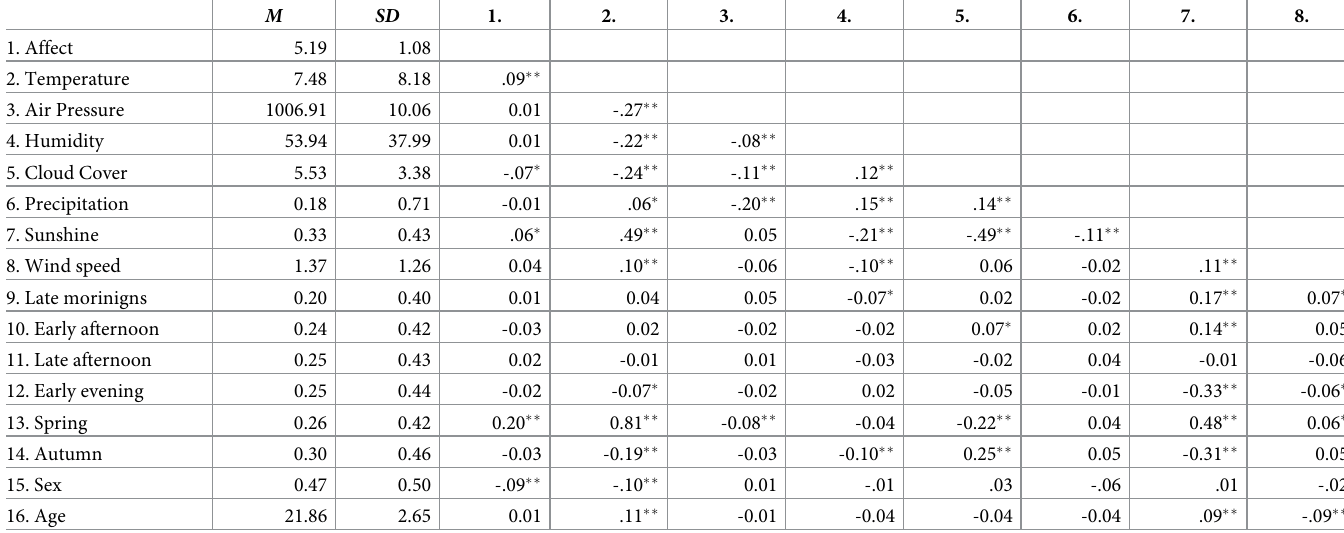
Table 2. Correlations among study